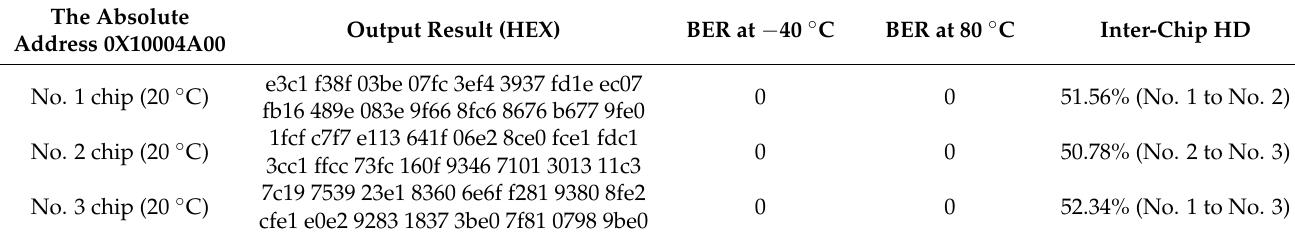
Table 3. The performance of absolute address 0X10004A00 in three chips.